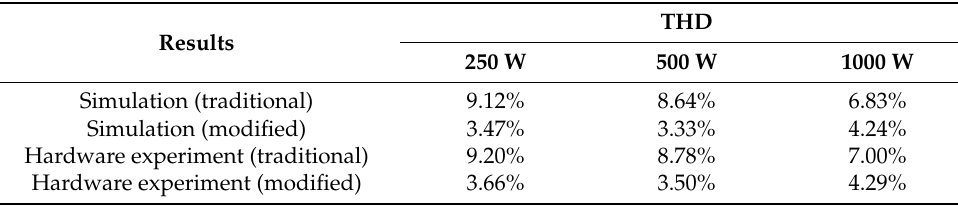
Table 3. Comparison of the THD in the results of the simulations and hardware